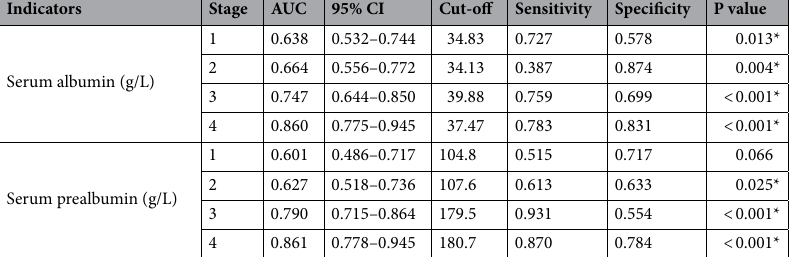
Table 4. ROC curve of albumin and prealbumin for the death of patients with severe acute pancreatitis.